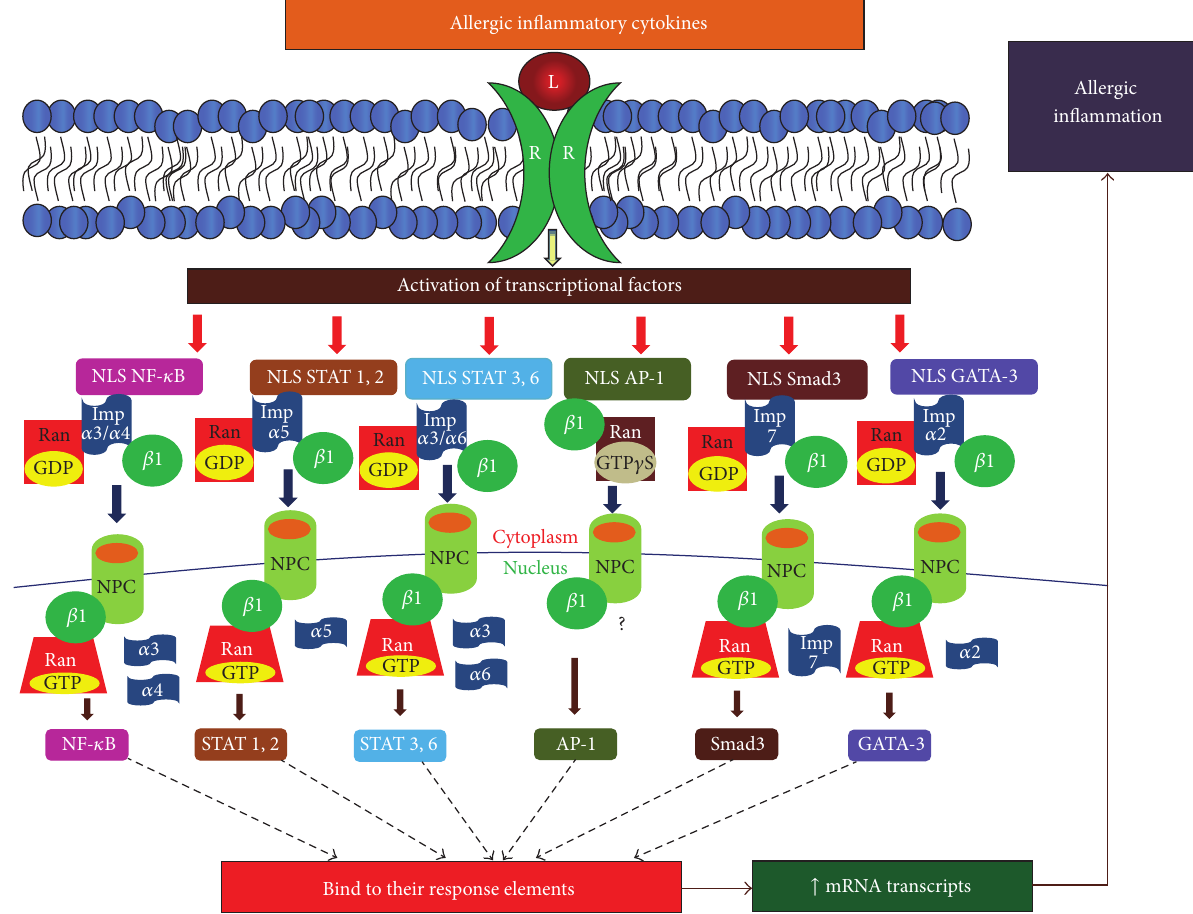
Figure 3: Binding of specific importin molecules to transcription factors: the figure shows the recognition of nuclear localization signal (NLS) by specific importin (Imp) molecules on activated transcriptional factors in the cytoplasm, binding of importin 𝛽 , and transport of the cargo to the nucleus through nuclear pore complex